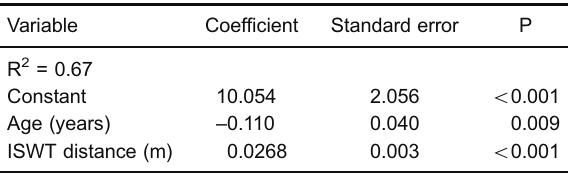
Table 3. Predictive model for cardiopulmonary exercise test (CPX) peak VO 2 using incremental shuttle walk test (ISWT) distance (ISWD) results in obese